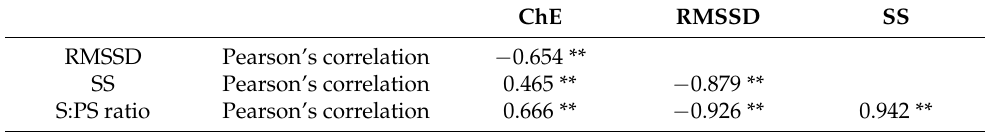
Table 3. Correlation between the variables ChE, RMSSD, SS, and the S:PS ratio.